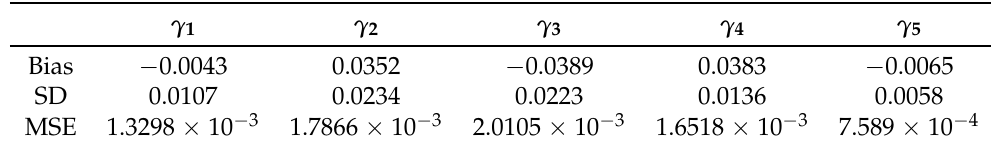
Table 7. Bias, SD and MSE evolutions with respect to the parameter γ variation for GNFPLSIM with the logistic link function and n = 500.